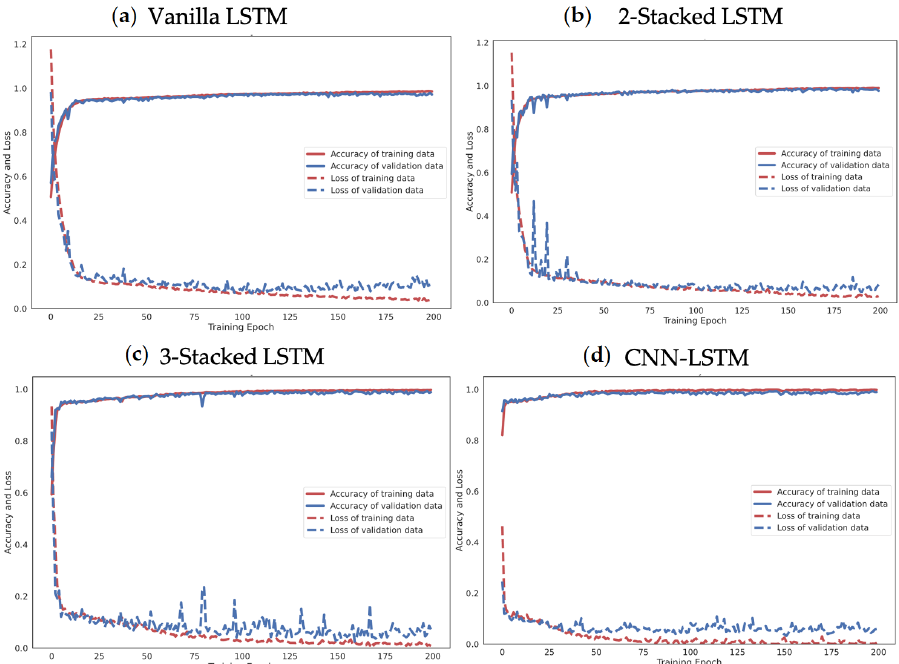
Figure 18. Accuracy and loss examples of training process of Vanilla LSTM, 2-stacked LSTM, 3- stacked LSTM, and